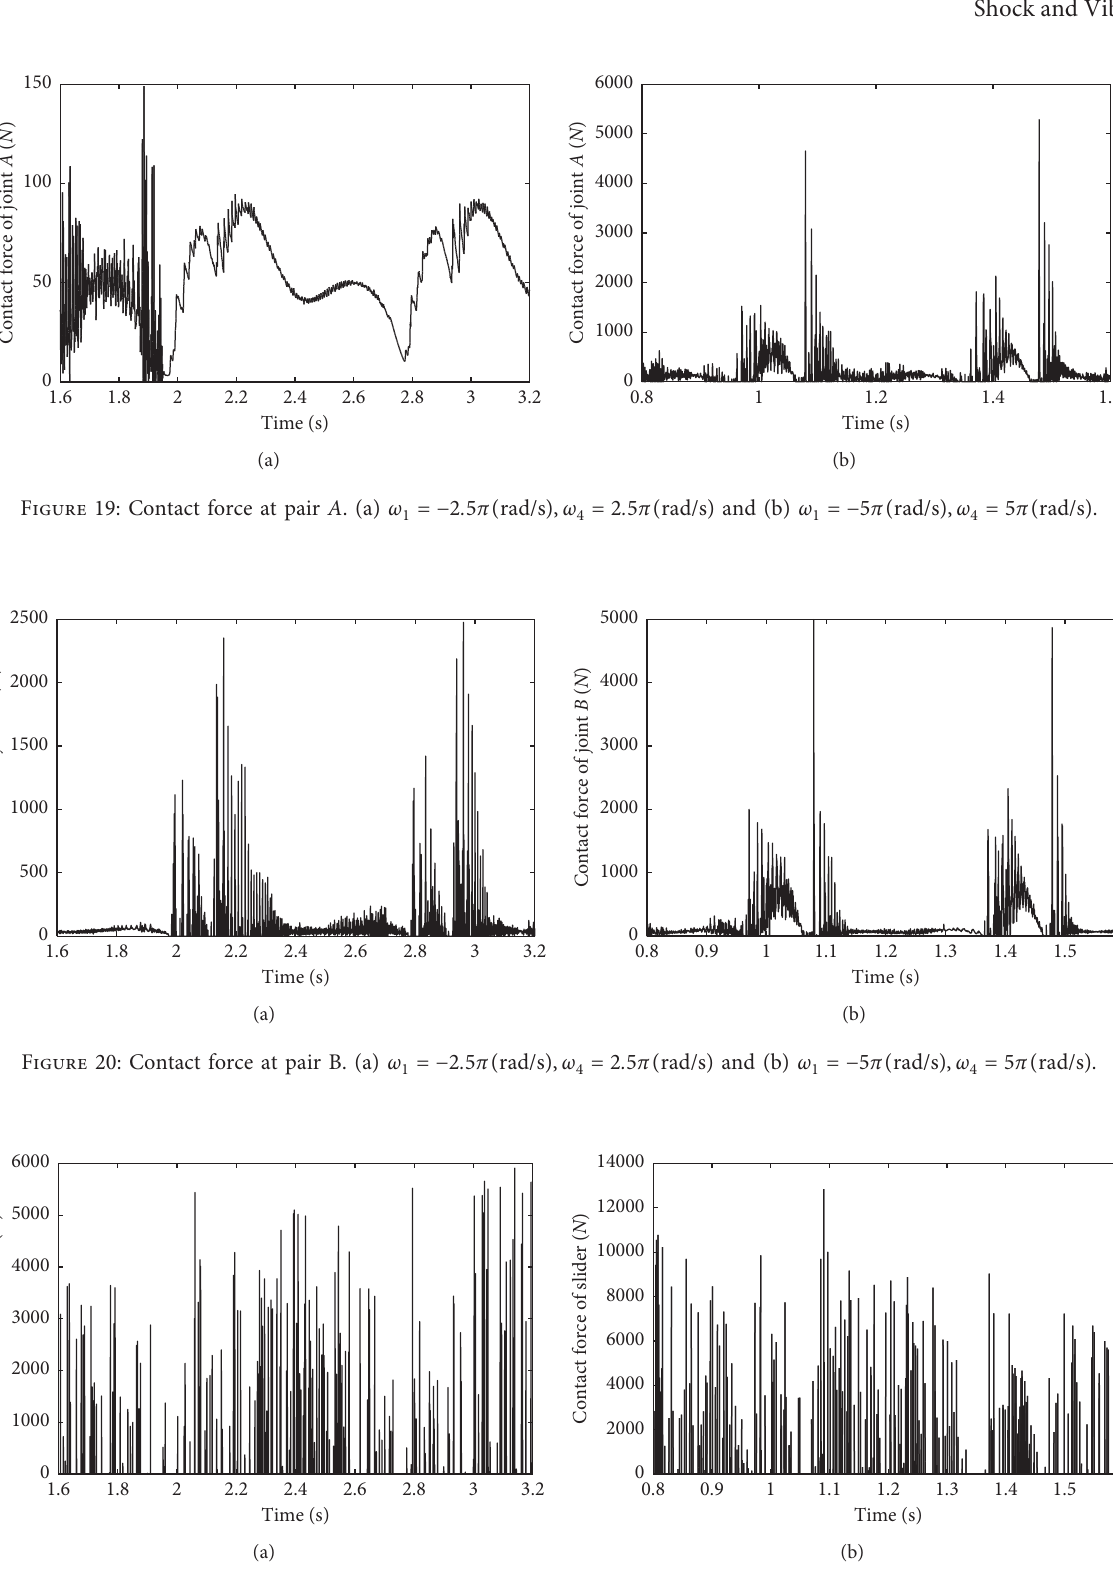
� − 2 . 5 π ( rad/s ) , ω 1